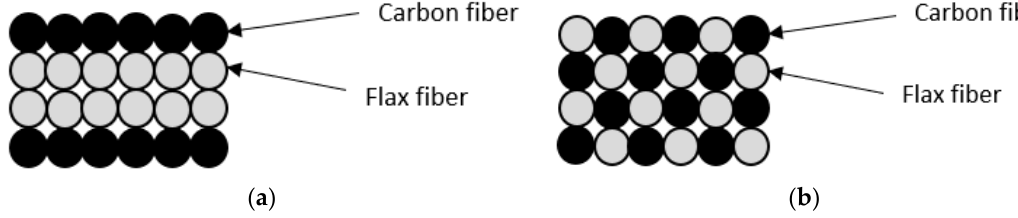
Figure 6. Schematic diagram of cross-section of fibers of ( a ) inter-ply hybrid composites, ( b ) Intra-ply hybrid composites.